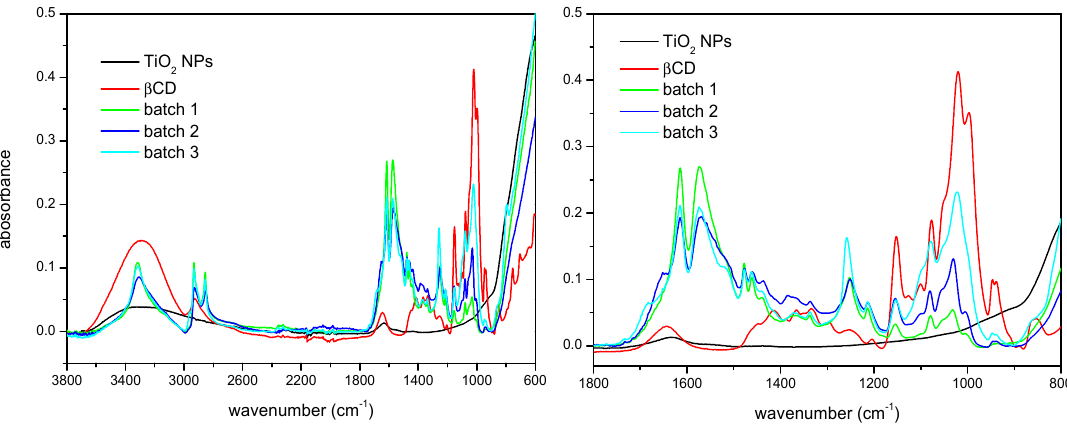
Figure 1. ( Left ) Full Fourier transform infrared spectroscopy-attenuated total reflectance (FTIR-ATR) spectra. ( Right ) Zoomed view of the as-received TiO 2 NPs, β CD, and β CDTiO 2 NPs (batches 1, 2, and 3).